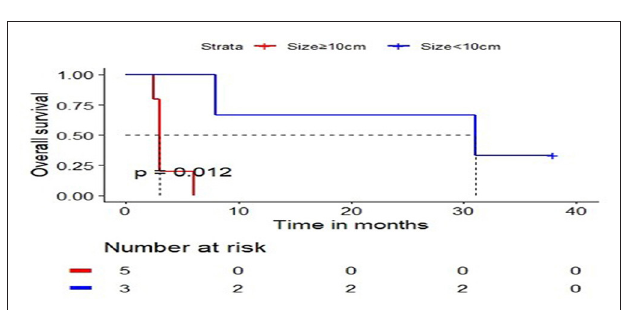
FIGURE 4 | The relationship curve between tumor size and overall